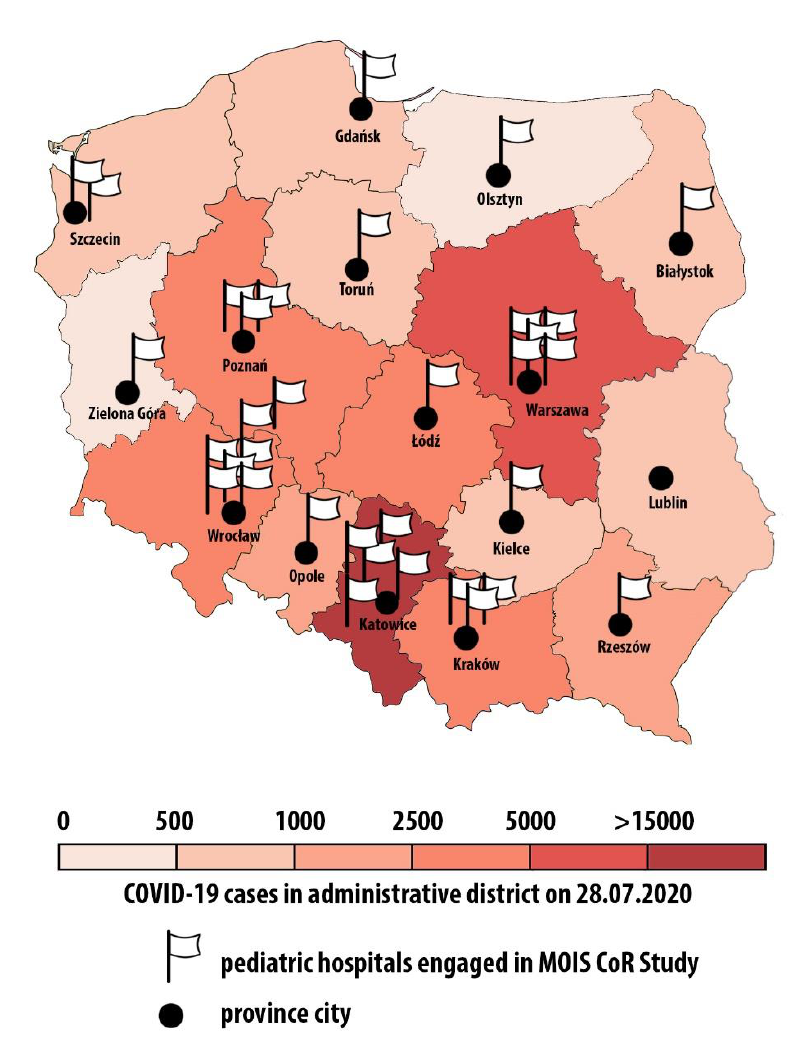
Figure 2. Pediatric hospitals engaged in the MultiOrgan Inflammatory Syndromes COVID Related Study (MOIS CoR Study)—Polish register of pediatric inflammatory syndromes during COVID-19 pandemic.